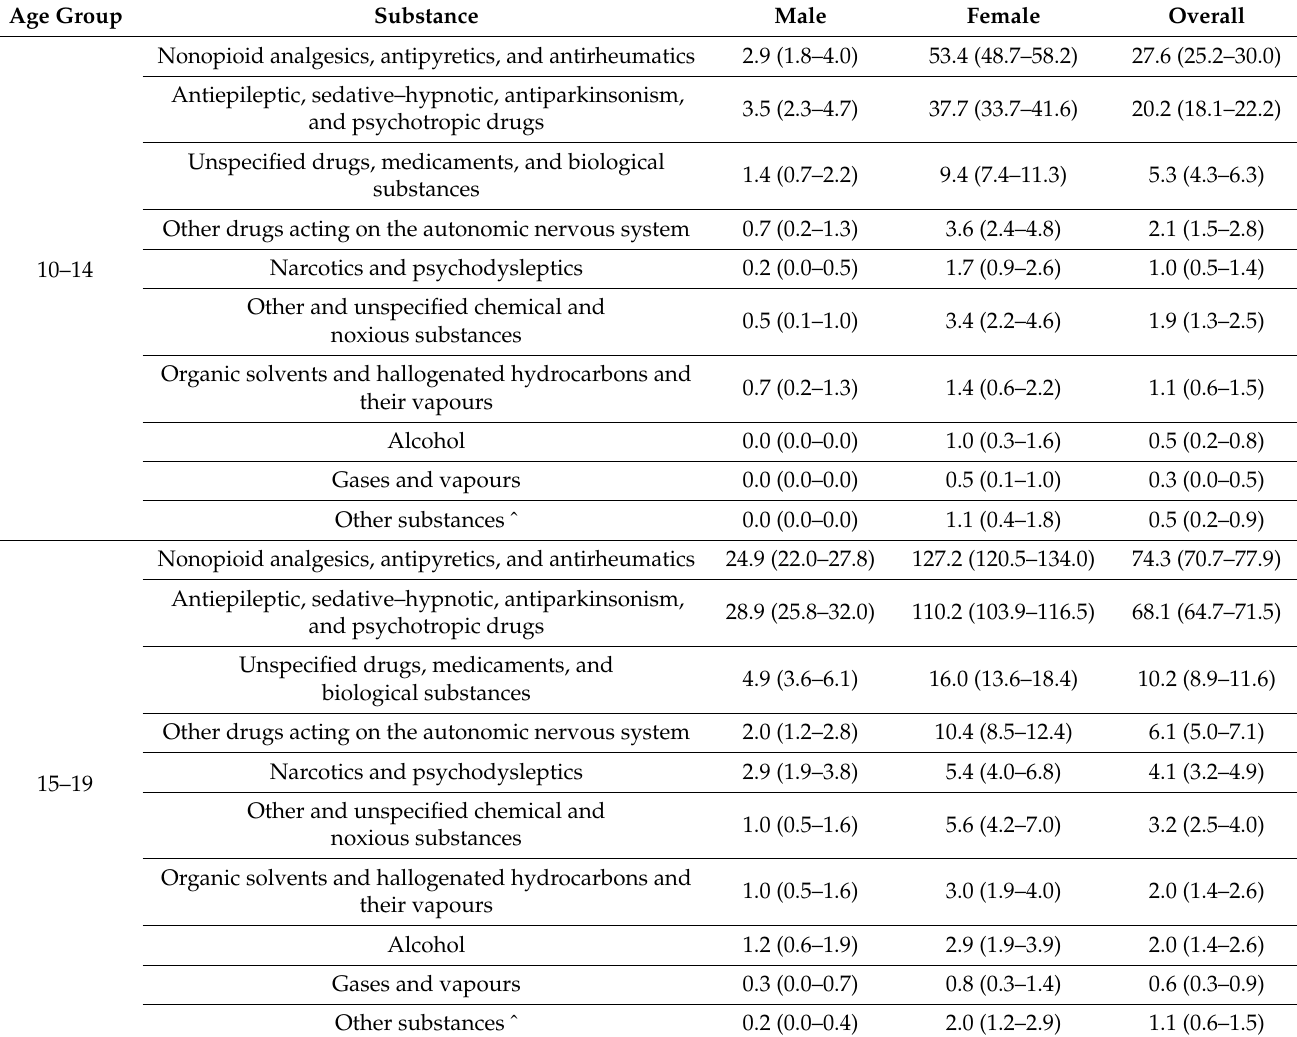
Table 1. Rates per 100,000 population, with 95% confidence intervals, for self-poisoning hospitalizations, 1 April 2012 to 31 March 2020, by poisoning substance, sex, and age